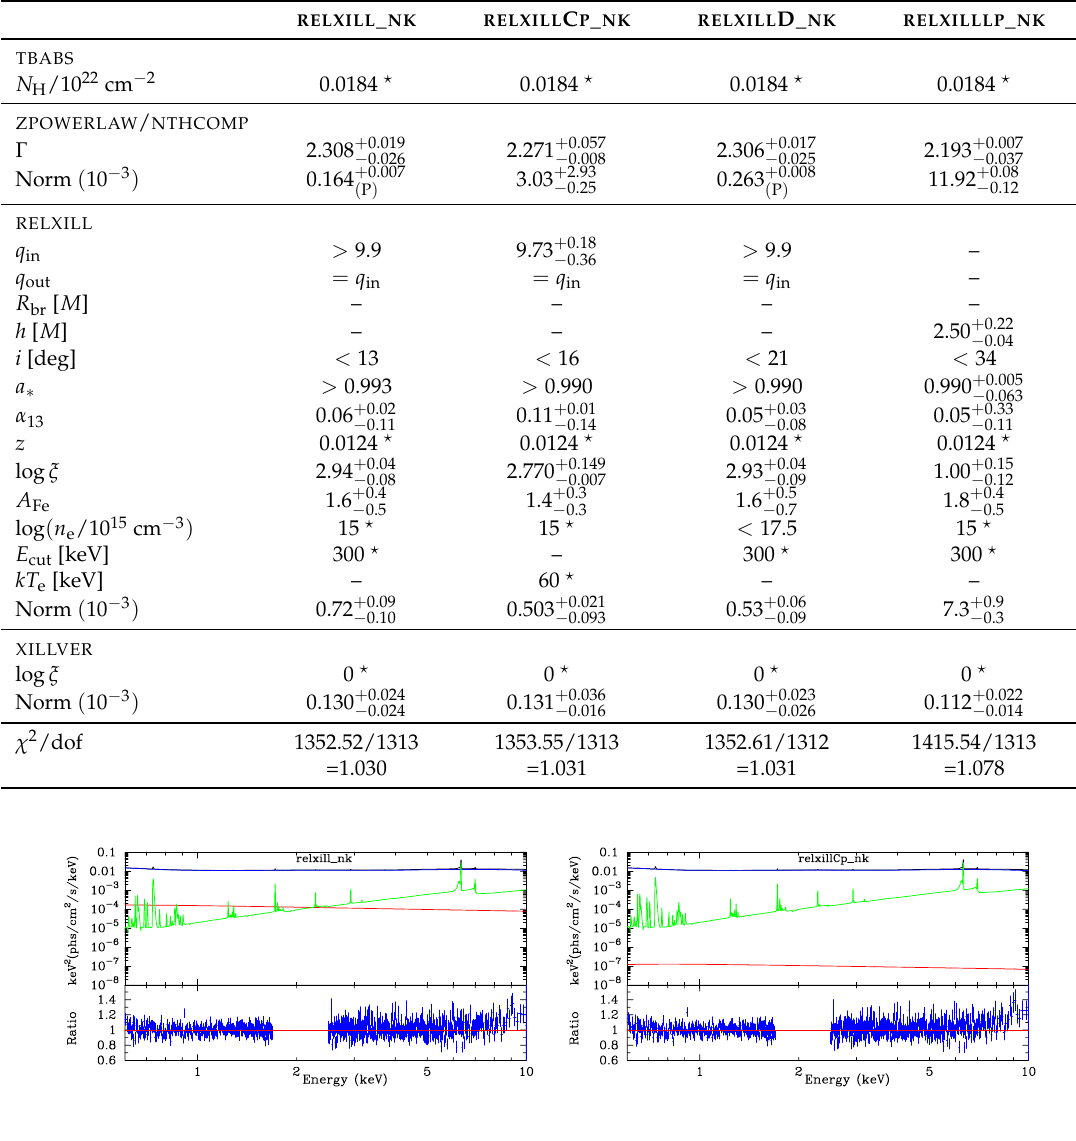
Table A4. Summary of the best-fit values for the supermassive black hole in Swift J0501–3239. (cid:63) indicates that the parameter is frozen to that value in the fit.